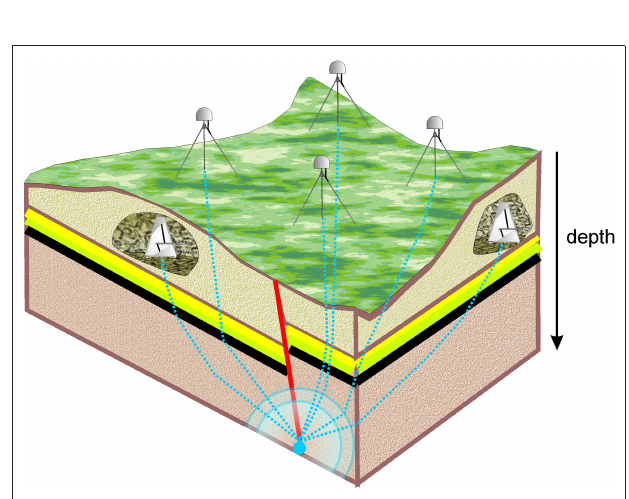
FIGURE 2 | Conceptual model of a porosity wave originating at a fault (red line) and propagating in the hosting rocks. Geodetic instruments, namely, tiltmeters-horizontal pendulums (installed underground, when possible, in natural caves) and GNSS sensors (on the surface) record the induced deformation at different times, depending upon the path of rays, normal to the propagating front (blue dashed lines).